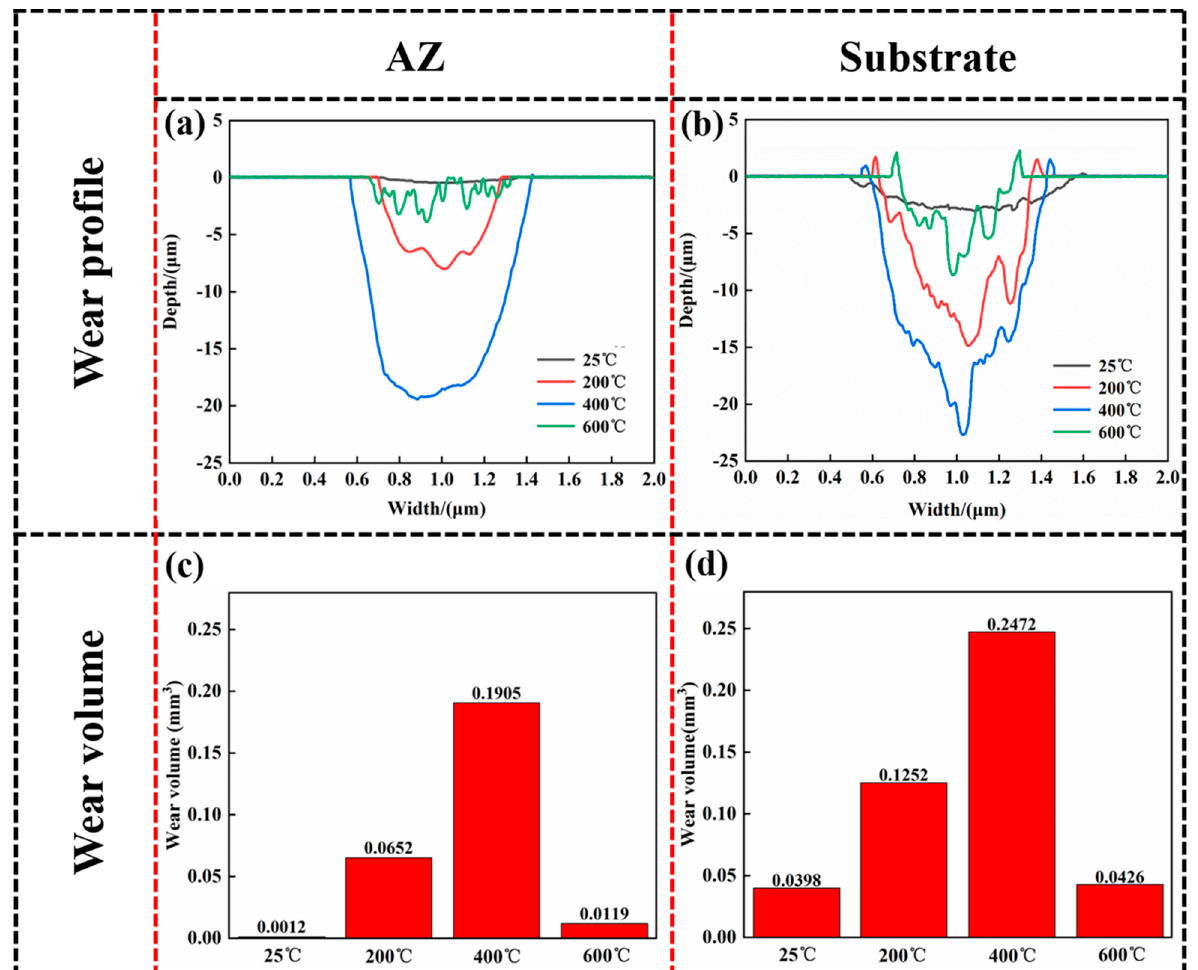
Figure 5. Wear profile and wear volume of AZ and substrate at different temperatures: ( a ) Wear profile of AZ, ( b ) Wear profile of substrate, ( c ) Wear volume of AZ, ( d ) Wear volume of substrate.